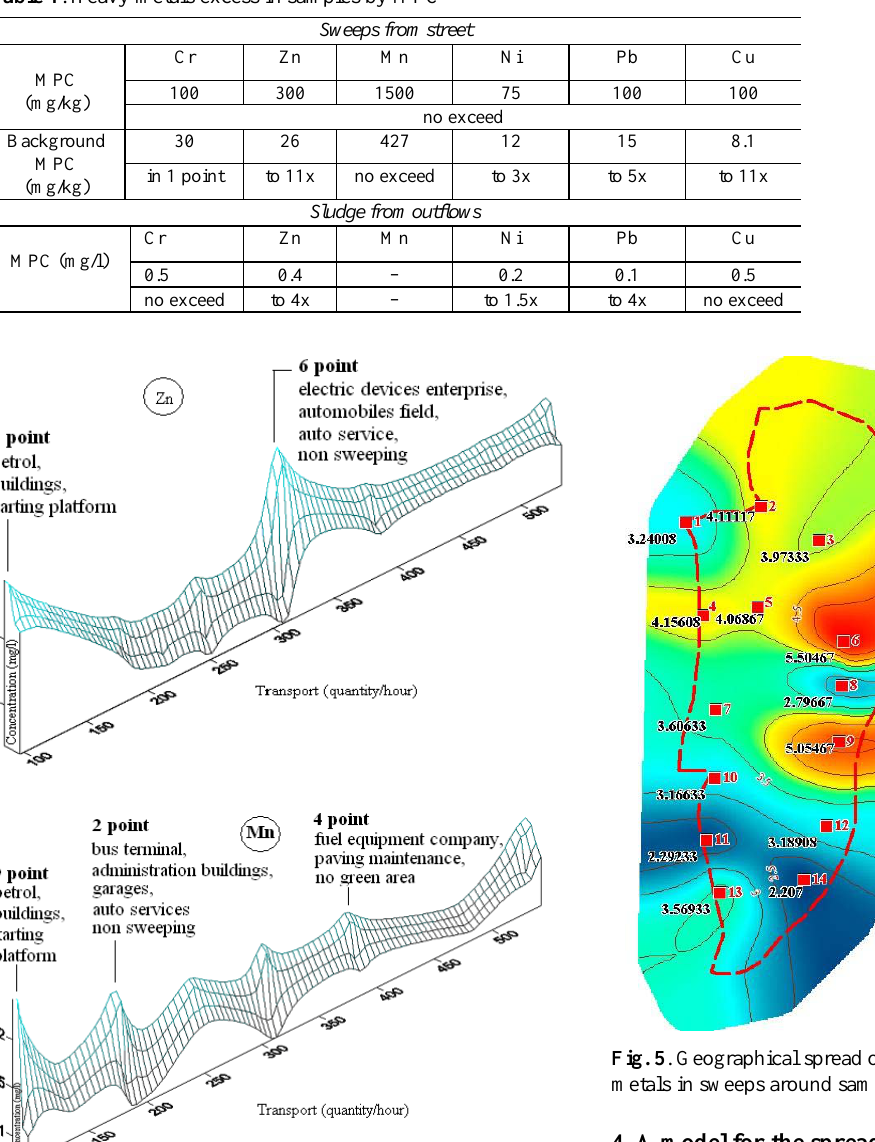
Table 1 . Heavy metals excess in samples by MPC